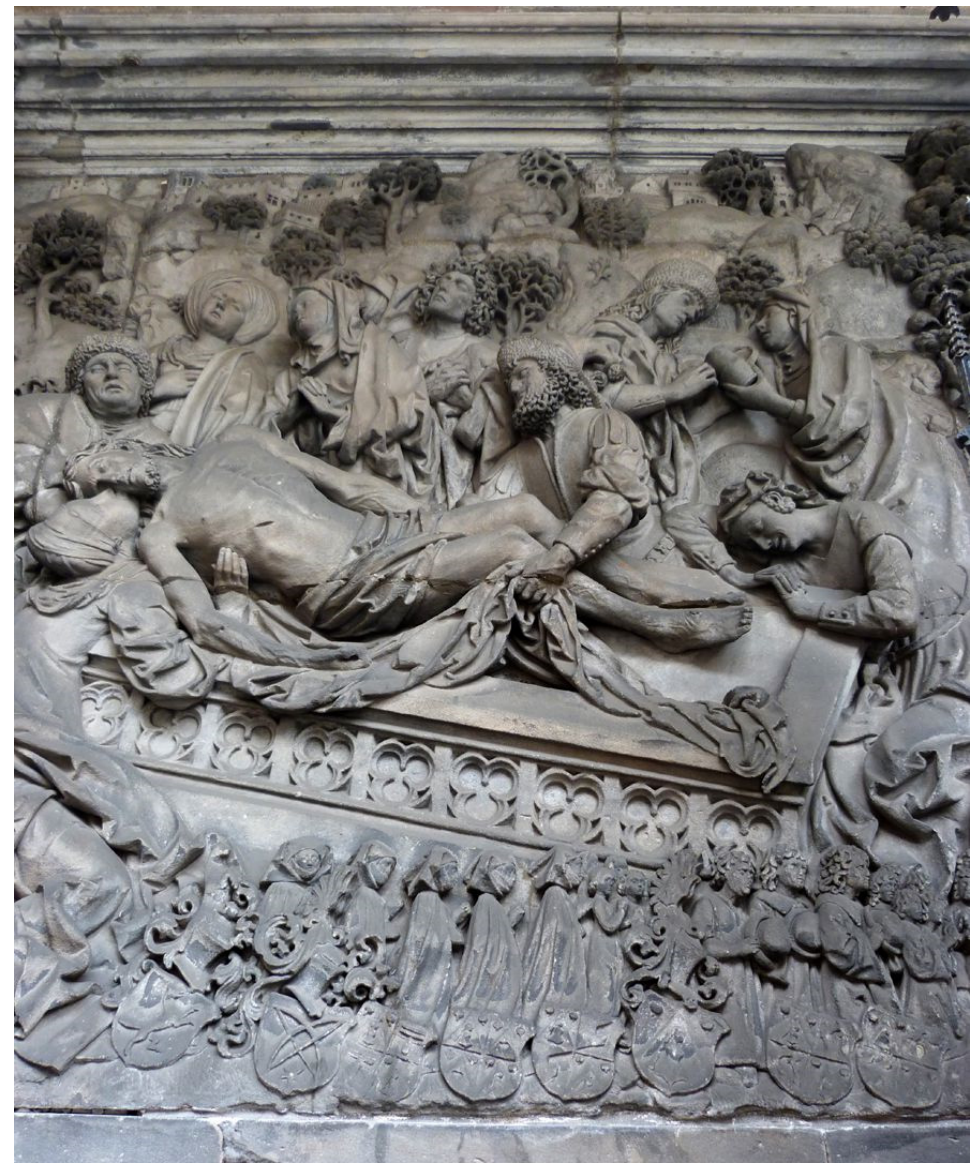
Figure 3. Kraft, Schreyer–Landau monument, detail: Donors and Deposition of Christ. This arrangement closely parallels Dürer’s own pair of painted epitaphs of Passion scenes, both painted around 1500: the Lamentation (c. 1500/03; Munich, Alte Pinakothek; Figure 4), painted for the goldsmith Albrecht Glimm, and the Lamentation (Nuremberg, Germanisches Nationalmuseum), a memorial for the prominent Holzschuher-Gruber family, also placed originally inside St. Sebald’s. 7